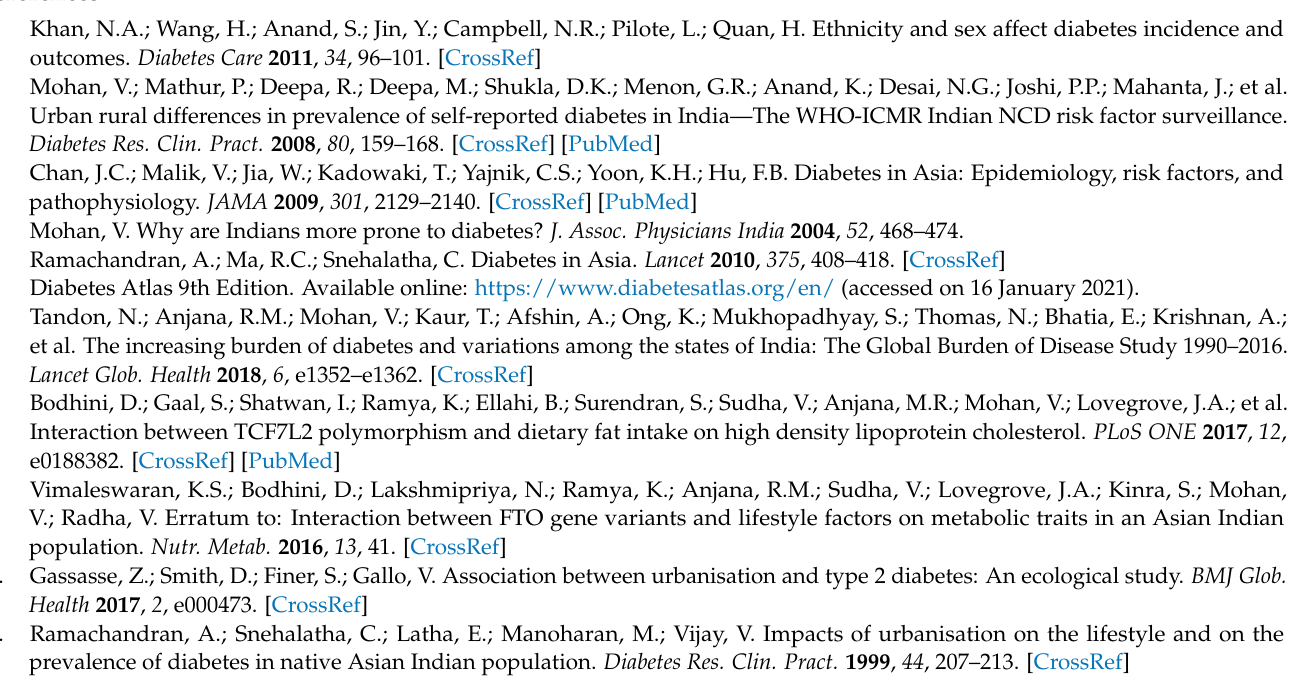
Figure S2: Interaction between 3-SNP GRS and animal protein intake (%) on fasting plasma glucose and glycated haemoglobin after adjusting for anti-diabetic